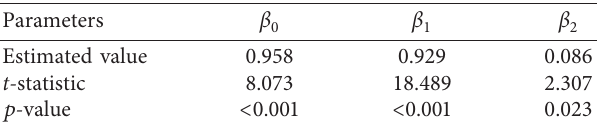
Table 2: Parameter estimations of boarding time model based on